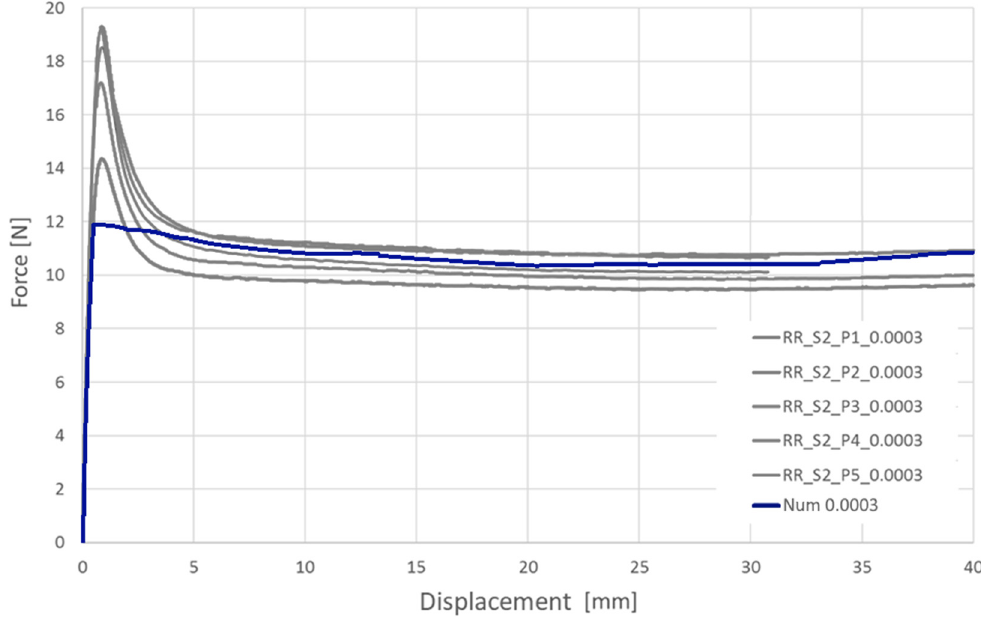
Figure 9. Comparison of the experimental and corresponding numerical results of tension forces during longitudinal tensile tests of tubes made of PLGA bioresorbable polymer: variant 1:0.72 mm/min.